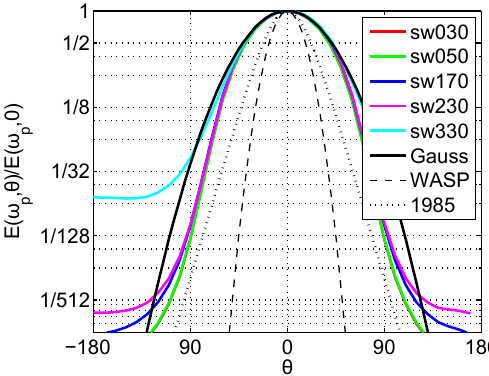
Figure 4. Normalized frequency spectra for direction θ = 0 ◦ after 11.5 days (approximately 10 6 s) of swell evolution for runs of Ta- ble 1 (see the legend).